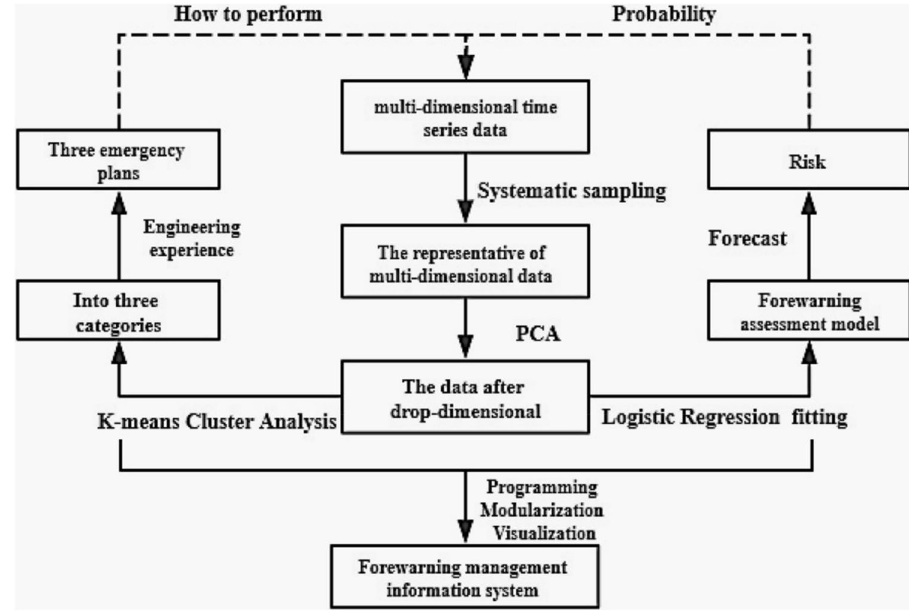
Fig. 4 Technical framework map (Wang et al.